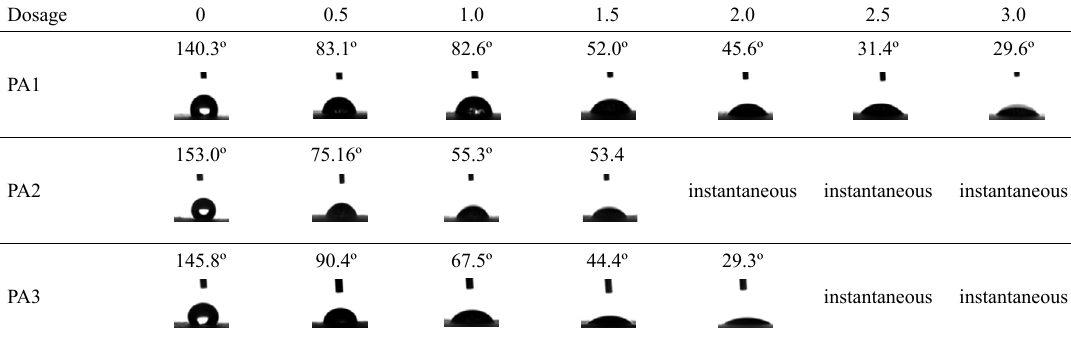
Table 3. Static Contact Angle for Polyamide Fabrics (Dosage: kW.min.m -2 )